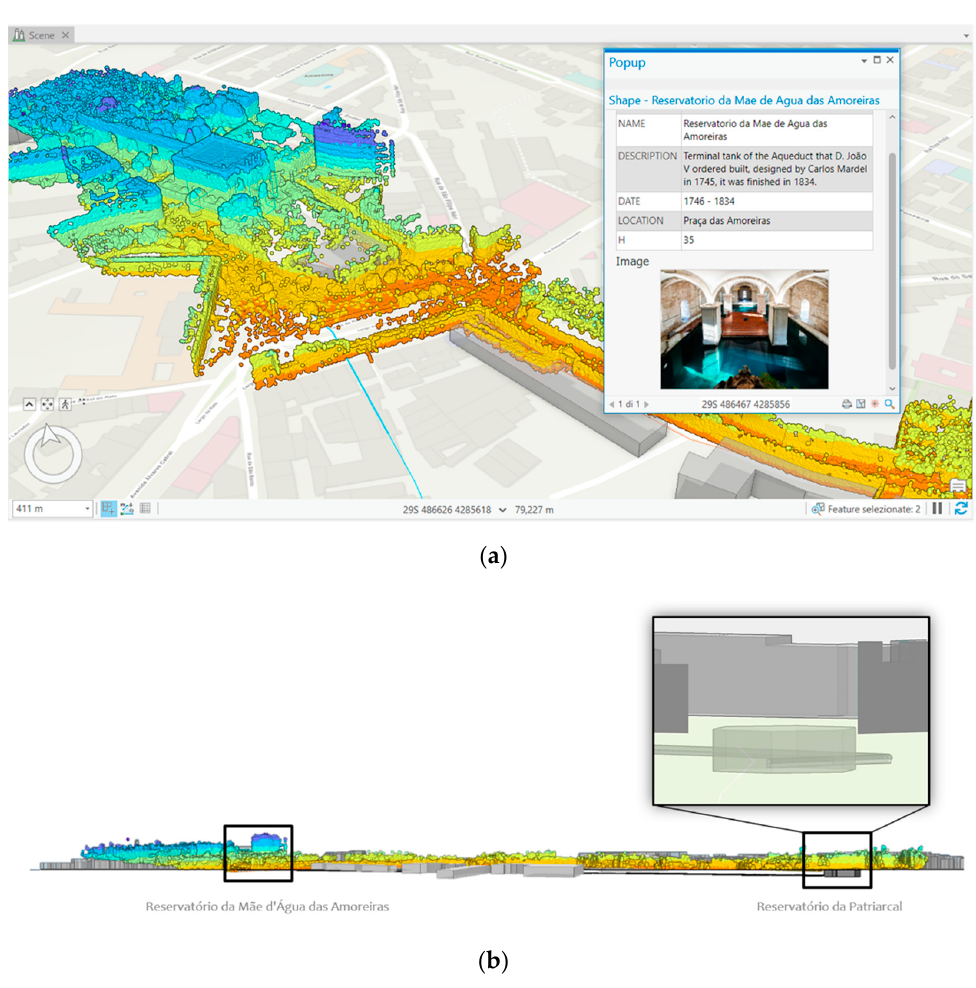
Figure 13. Data integration of point cloud overlapping the 3D models in 3D GIS environment: ( a ) aerial view; ( b ) front view with zoom on the 3D model of part of the underground environment.